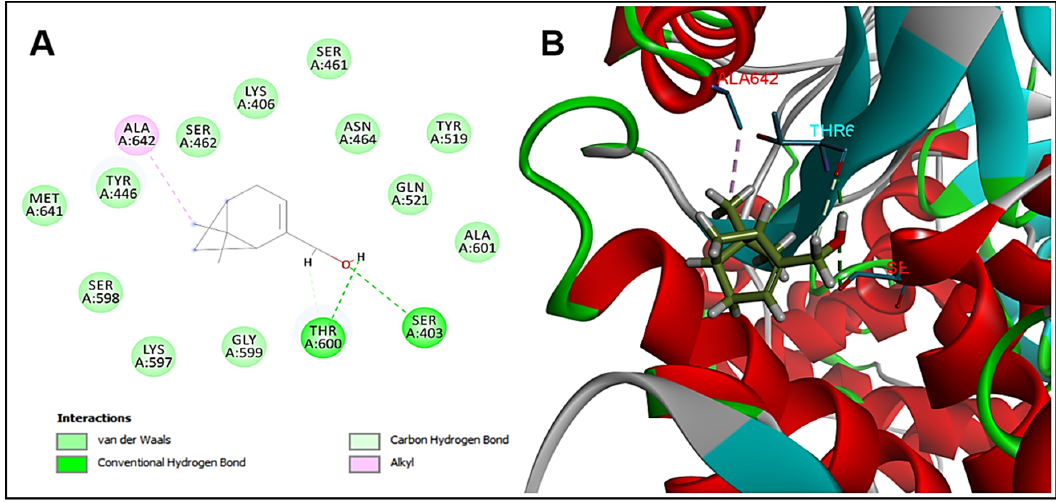
Figure 2. Molecular docking analysis. ( A ) Two-dimensional and ( B ) three-dimensional representation of myrtenol interactions in the PBP2 active site.